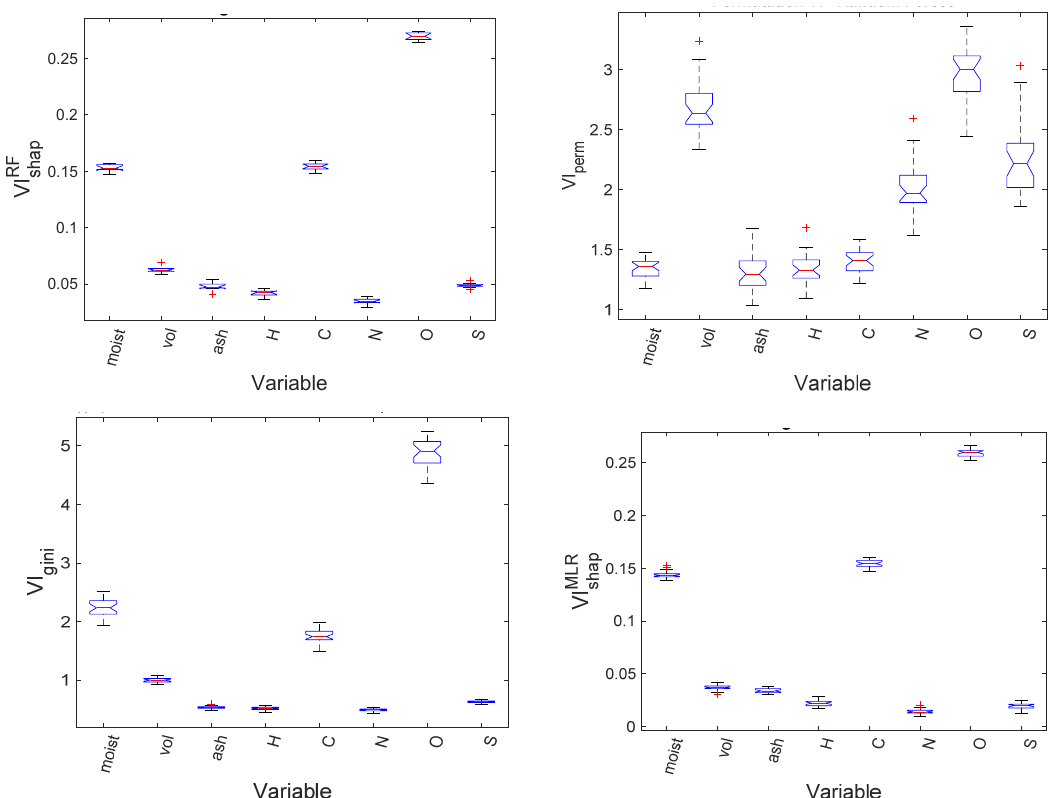
Figure 9. Variable importance analysis with the Shapley regression forest (top, left), permutation random forest (top, right), Gini random forest (bottom, left), and Shapley linear regression (bottom, right), based on 30 runs.